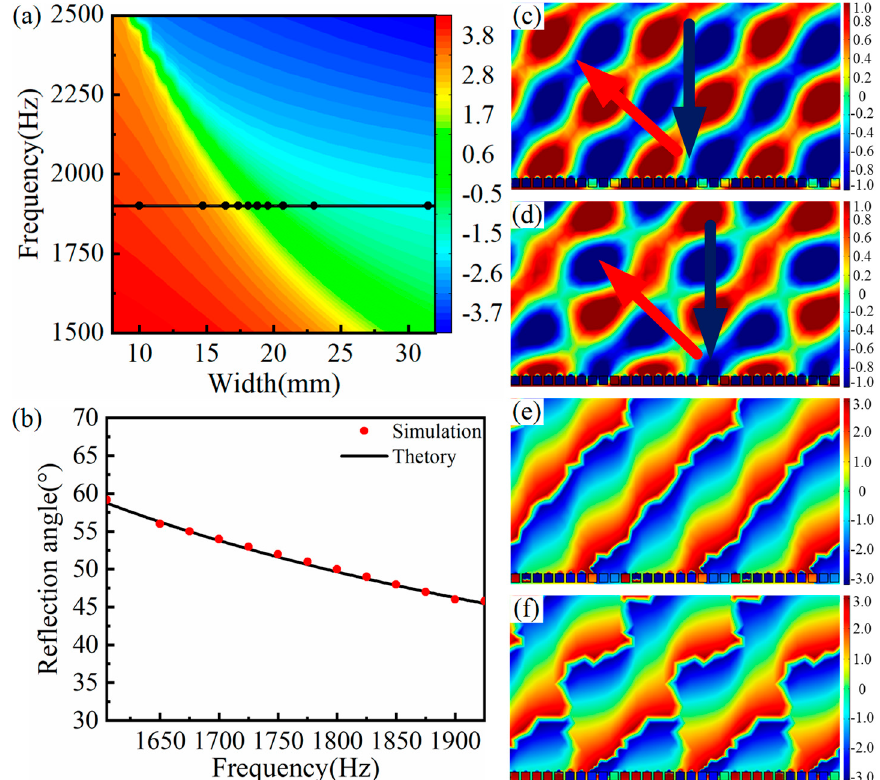
Figure 6. AMS of ten SHCs with different widths at the phase gradient of π /125 rad/mm. ( a ) The reflection phase modulation map, where the corresponding frequency of the black curve is the designed center frequency and the corresponding width of the black circle symbols is chosen as the width of ten SHCs; ( b ) the AMS relationship curve between frequency and the anomalous reflected angle; ( c ) and ( d ) reflected acoustic pressure field distribution at 1850 Hz and 1900 Hz; and ( e ) and ( f ) reflected phase distribution of corresponding (c) and (d), respectively.